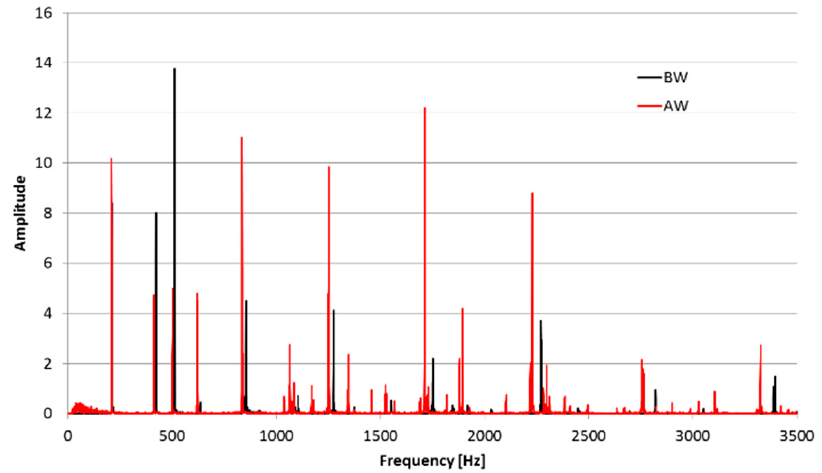
Figure 9. The spectrum of the St. Maryan bell’s sound, before (BW) and after (AW) welding.